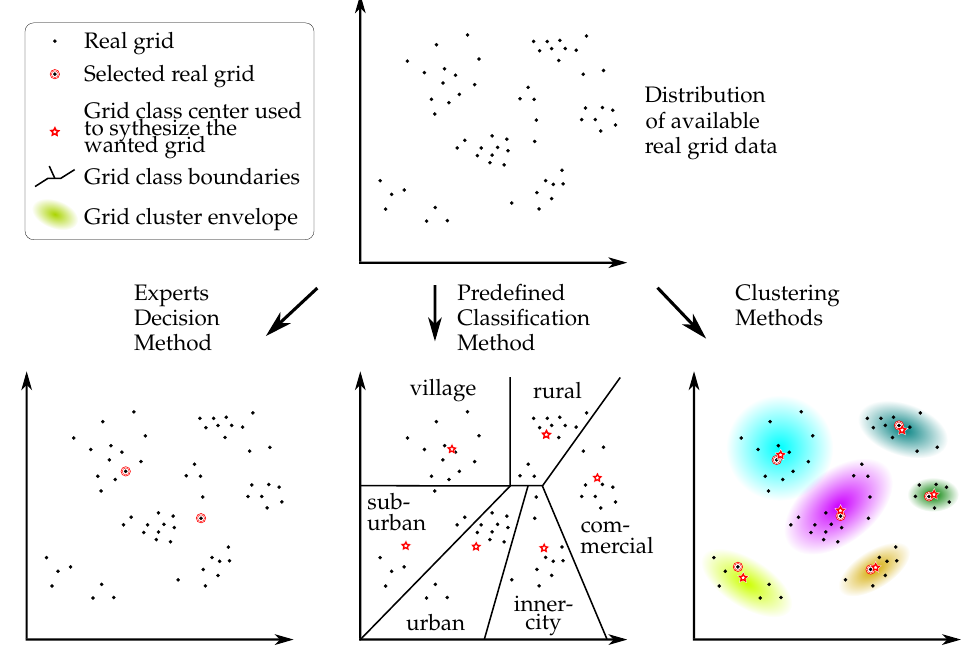
Figure 1. Grid selecting illustration of grid generation methods based on experts decisions ( left ), using urbanization class assumptions ( center ), without predefined grid classification ( right